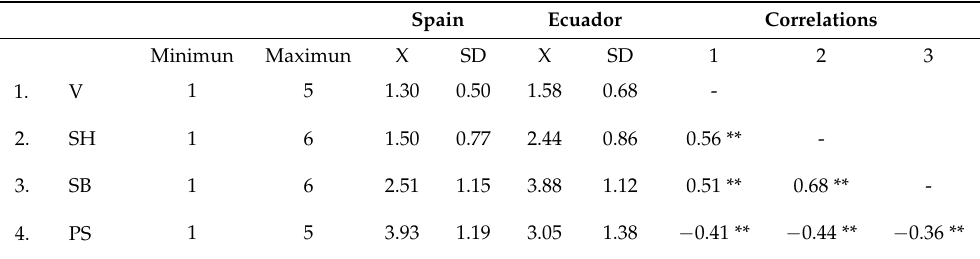
Table 3. Descriptive